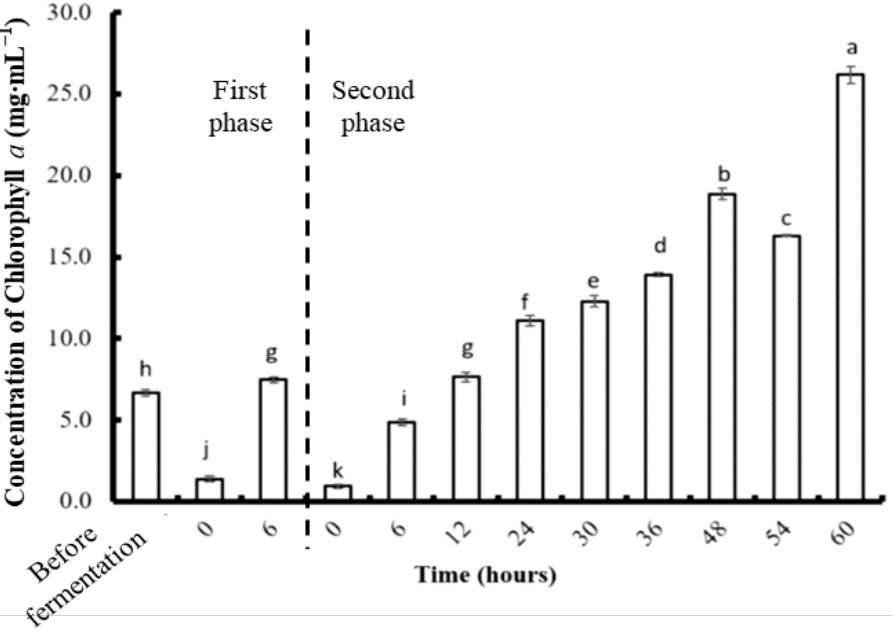
Figure 9. The concentration of chlorophyll a in Colaconema formosanum before and during two-phase fermentation with Pseudoalteromonas haloplanktis , ATCC 14393. Lowercase letters (a, b, c . . . ): concen- tration of chlorophyll a between each fermentation time; uppercase letters (A, B, C…): con- tent of chlorophyll a between each fermentation time ( n = 3, Duncan’s test, p < 0.05).